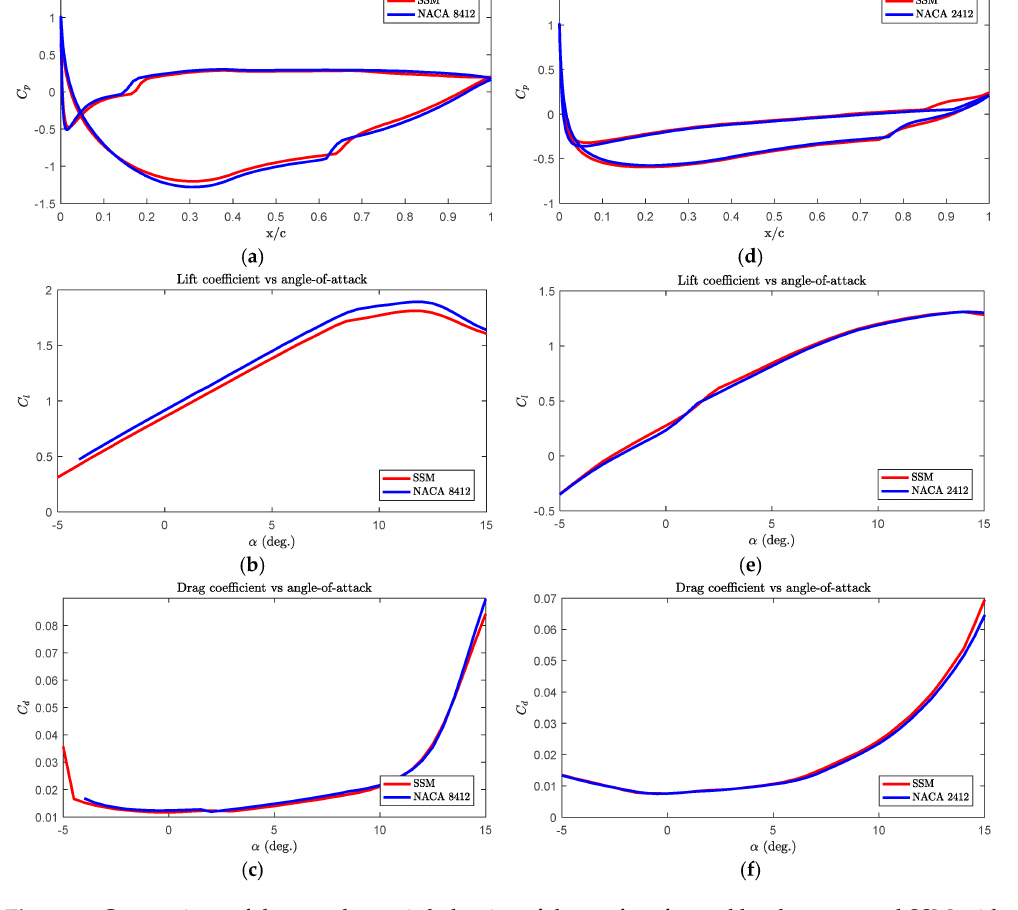
Figure 9. Comparison of the aerodynamic behavior of the surface formed by the proposed SSM with N = 6 SLEs at the position of the baseline airfoil morphed into NACA 8412: ( a ) pressure distribution; ( b ) lift coefficient vs. AoA; ( c ) drag coefficient vs. AoA; and the surface formed by the proposed SSM with N = 6 SLEs at the position of the baseline airfoil morphed into NACA 2412: ( d ) pressure distribution; ( e ) lift coefficient vs. AoA; ( f ) drag